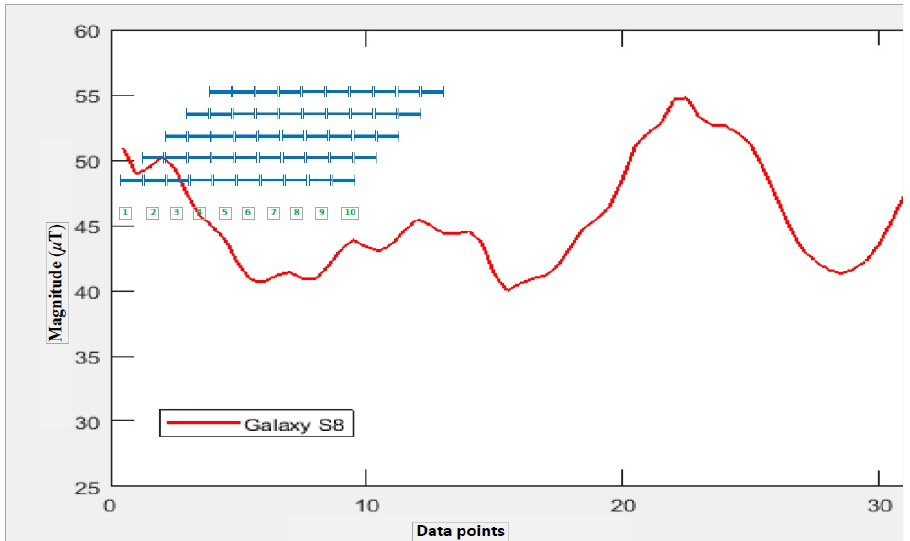
Figure 10. Geomagnetic positioning algorithm